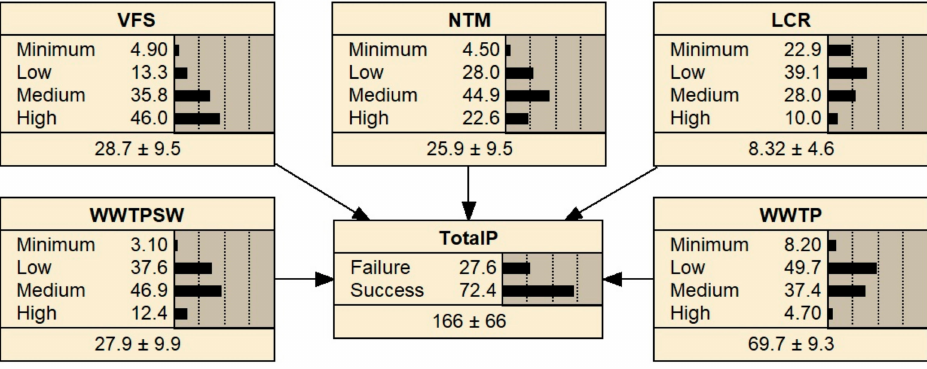
Figure 4. Results of the Bayesian network showing probability of achieving the “good